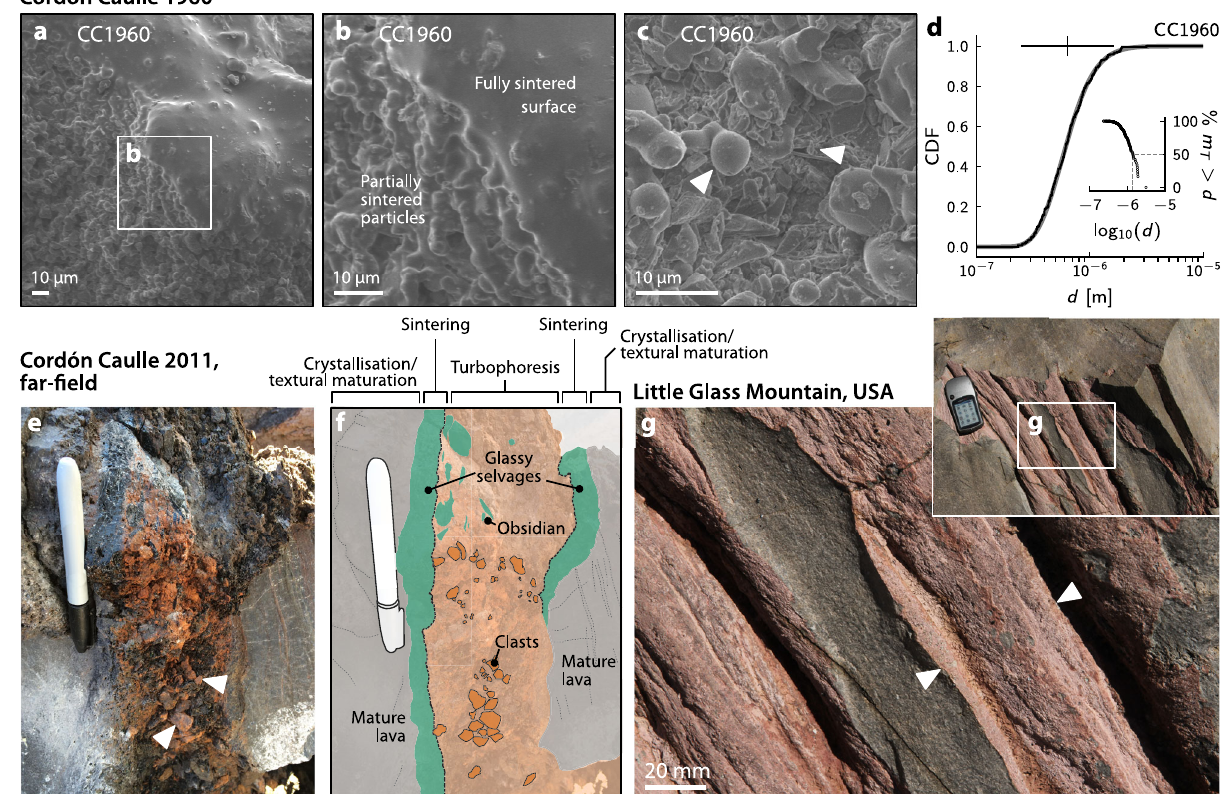
Fig.6|Extended fi eldobservations.a – c SEMimagesofsampleCC1960,collected from Cordón Caulle 1960 CE eruptive vent. In c , both near-spherical and angular particles can be observed. d Particle size distribution for sample CC1960, as in Fig. 2. e Detail of veneered fracture surface distal from the main vent at Cordón Caulle. Arrows highlight millimetric-to-centimetric clasts sintered to the fracture surface. Marker pen is ~14cm. f Schematic interpretation of e , indicating laterally juxtaposedzonesthathadexperiencedvariousprimaryoperativeprocessesduring